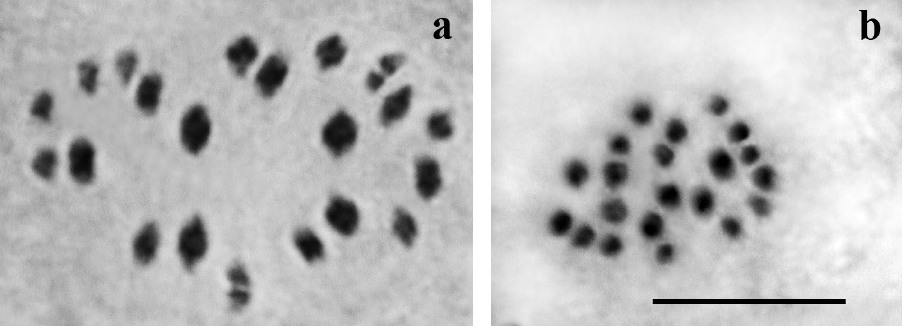
Figure 3. Male karyotype of Polyommatus ( Agrodiaetus ) shirkuhensis. a metaphase I, n = 21 b metaphase II, n = 21. Bar =